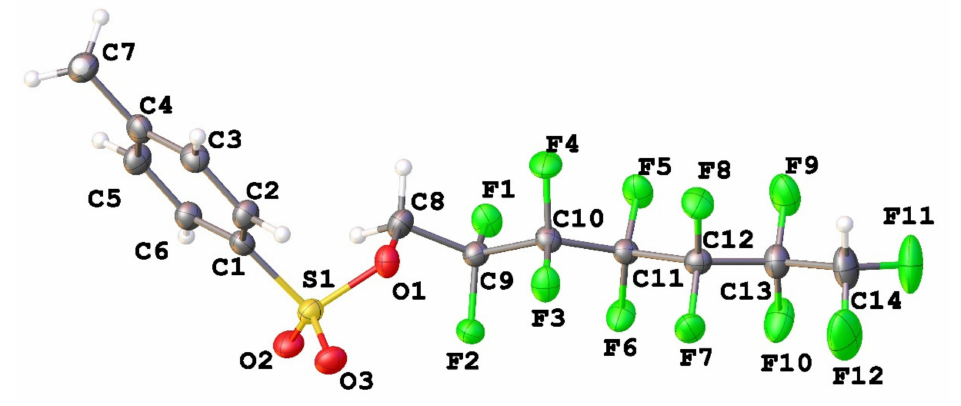
Figure 4. Molecular structure of 3a . Atoms are presented as thermal ellipsoids.